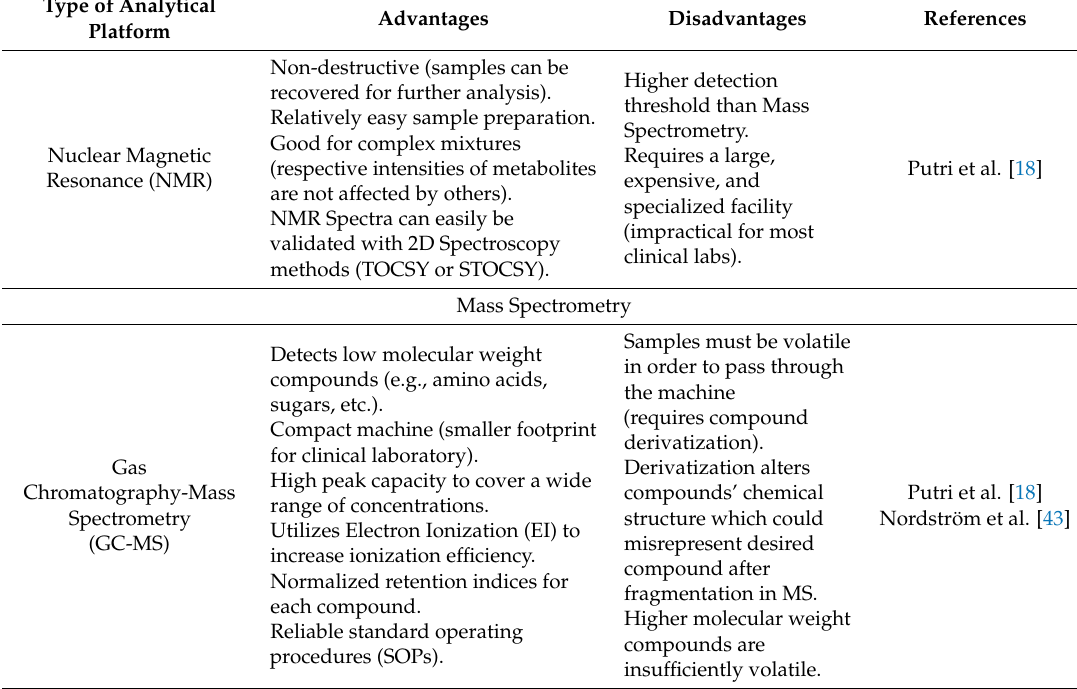
Table 2. Features of analytical platform for metabolomics that should be considered when devising a clinical assay based on